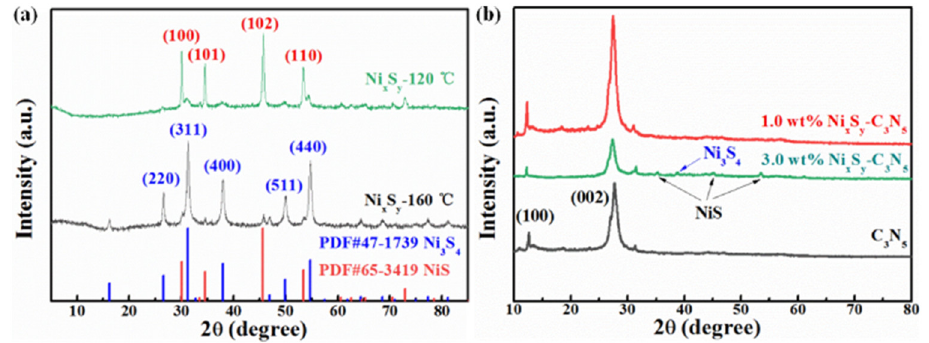
Figure 1. XRD patterns of ( a ) Ni x S y prepared using a hydrothermal procedure at 120 and 160 °C, and ( b ) C 3 N 5 and Ni x S y -C 3 N 5 with different Ni x S y loading amounts prepared using a hydrothermal procedure at 120 °C.